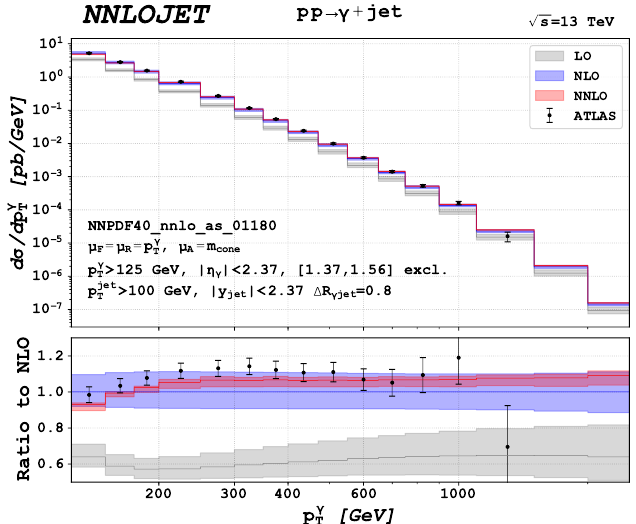
Figure 4. Predictions for the photon transverse momentum distributions at LO, NLO, and NNLO. The predictions are compared to data from the ATLAS measurement [14].